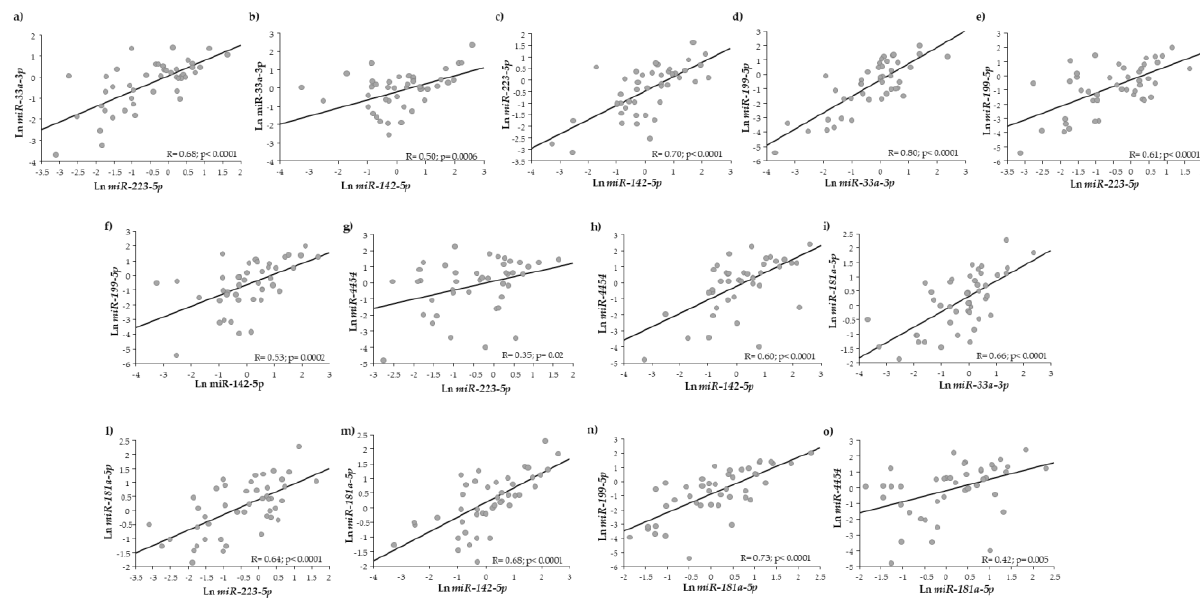
Figure 4. Correlations among exosomal miRNAs. Interestingly, we observed that some miRNAs significantly and positively correlated with metabolic and inflammatory indices. In particular, miR-142-5p correlated with total cholesterol (R = 0.45; p = 0.008) and LDL (R = 0.43; p = 0.02), miR-4454 with total cholesterol, HDL and LDL (R = 0.51; p = 0.004; R = 0.38; p = 0.03; R = 0.49; p = 0.008), and miR-181a-5p with LDL (R = 0.38; p = 0.03). PCR correlated significantly with miR-223-5p (R = 0.33; p = 0.05) and miR-199-5p (R = 0.41; p = 0.01). Including both obese and normal-weight subjects as dependent variables and miR- 181a-5p , miR-199a-5p , miR-223-5p , miR-33a-3p , and miR-4454 together with auxologic pa- rameters as predictors in a multivariate logistic regression model, we observed that miR- NAs were not significant predictors of childhood obesity (Table 2a). However, by replac- ing auxologic parameters with some metabolic indices in the regression model, as inde- pendent variables, we found that miR-4454 , and HDL (Table 2b) were independent pre- dictors of childhood obesity ( miR-223-5p was only marginally significant). Table 2. a) independent determinants of obesity (Response Variable: Auxologic Parameters); b) in- dependent determinants of obesity (Response Variable: Metabolic Indices) . a)